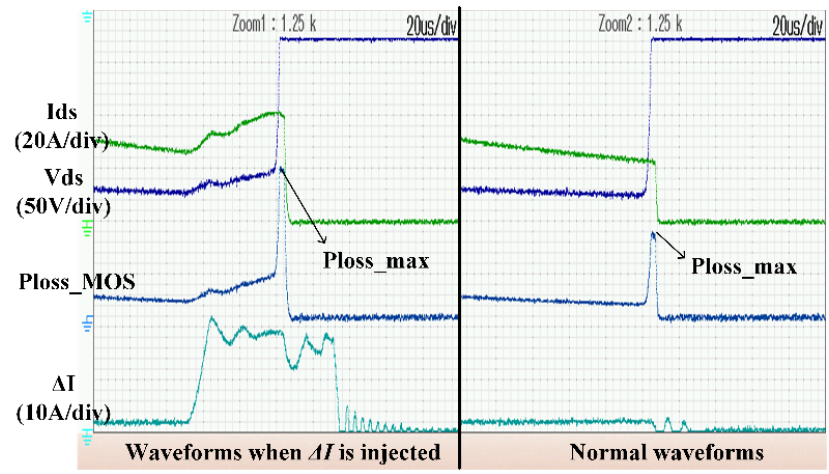
Figure 22. Comparison of turn ‐ off loss of MOSFET.